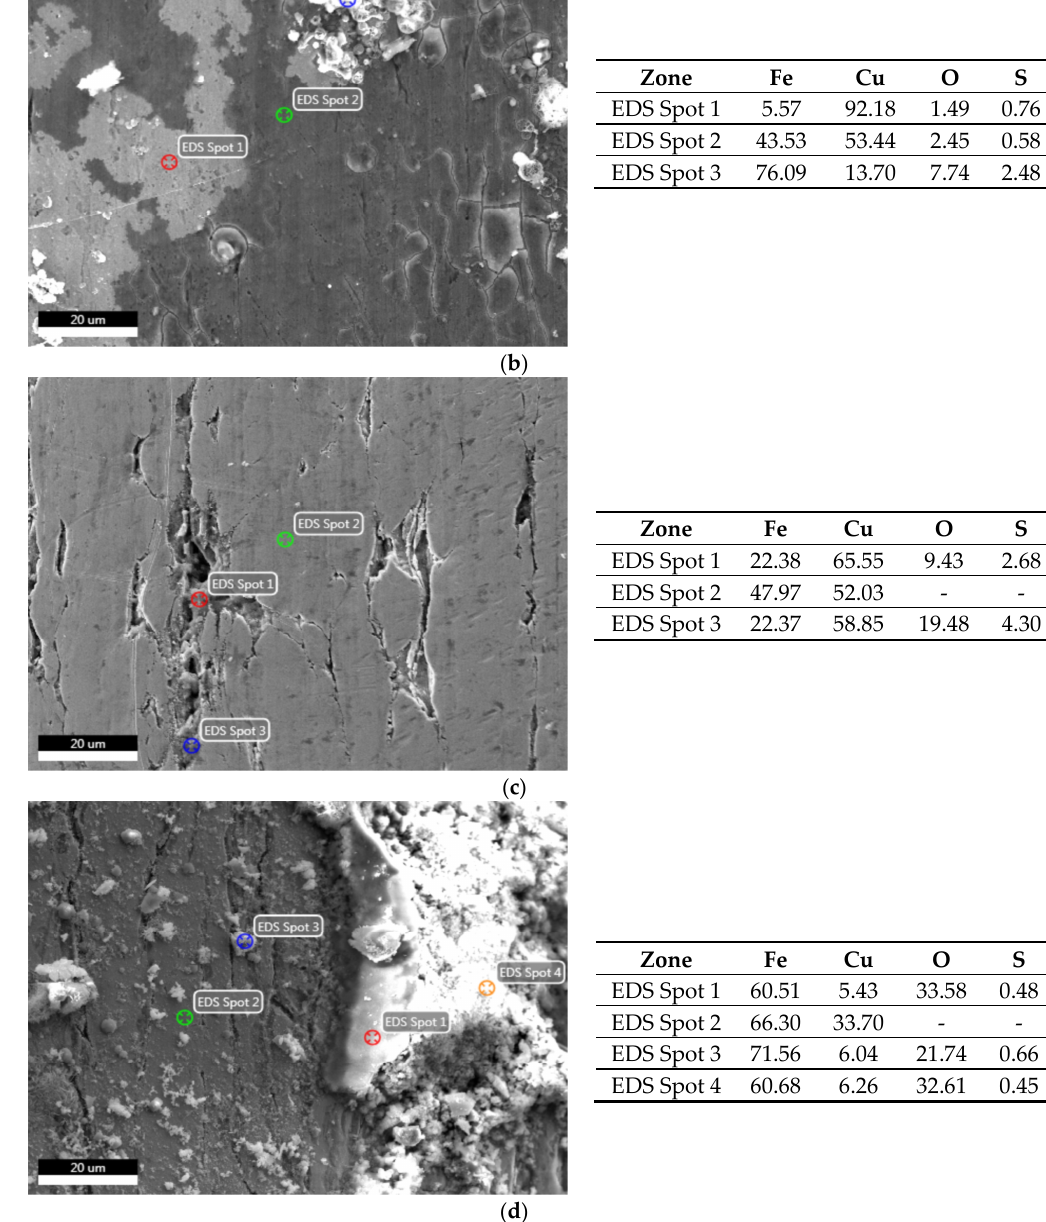
Figure 6. SEM image and spot EDS analysis of flux-cored wires: ( a ) A wire stored in GWS; ( b ) A wire stored in MAB; ( c ) B wire stored in GWS; ( d ) B wire stored in MAB.